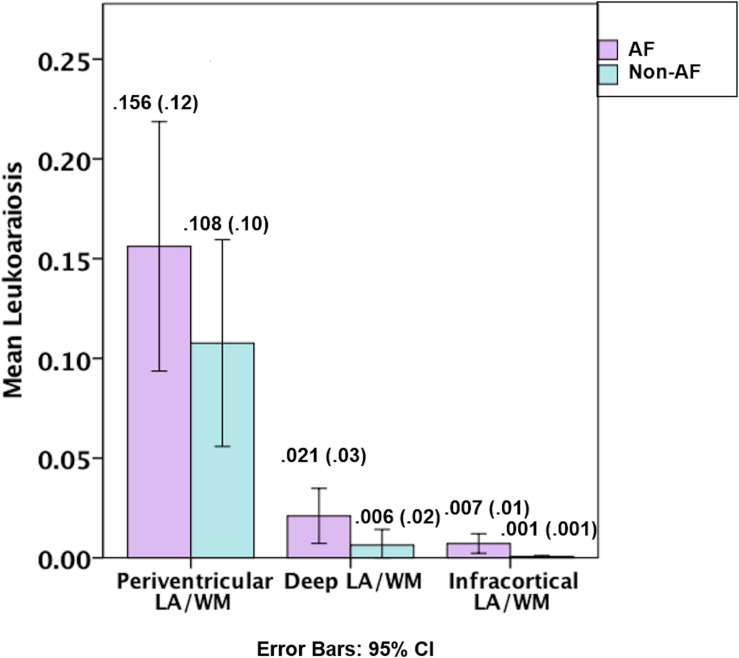
Graphical depiction of the distribution of leukoaraiosis as a percentage of white matter in periventricular, deep, and infracortical brain regions of individuals with atrial fibrillation (left; n = 17) and non-atrial fibrillation peers (right; n = 17). Mean (SD) for the percentage of leukoaraiosis within the white matter by depth for individuals with atrial fibrillation and non-atrial fibrillation peers.